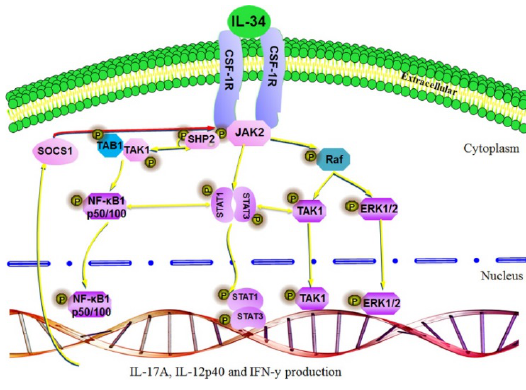
Figure 6. Summary and model for the potential function of the chIL-34 signaling pathway.